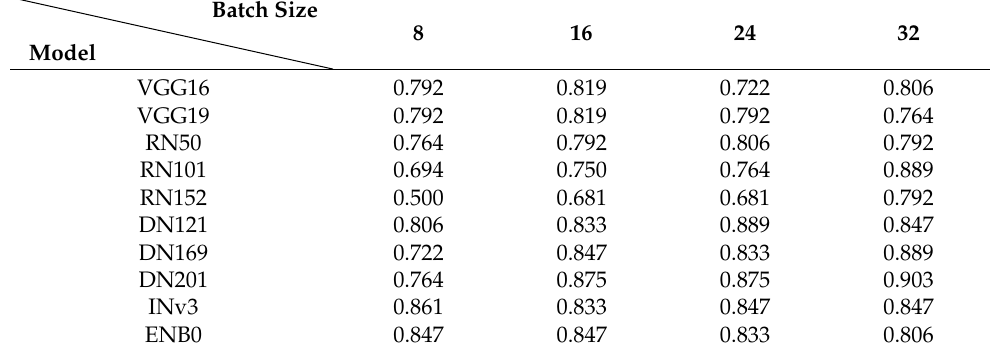
Table 6. Accuracies of compared CNNs for different batch sizes.